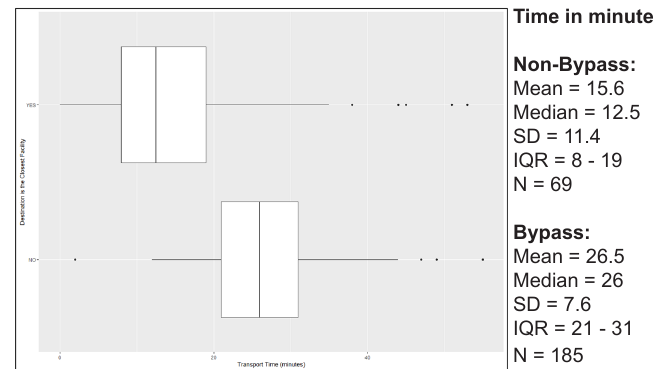
Figure 2. Comparison of actual transport time between bypass and non-bypass patients. Box and whisker plots represent median (middle line), IQR (borders of box from 25th (Q1) to 75th (Q3) percentiles), edges of lines represent values within (Q1 - 1.5*IQR) to (Q3 + 1.5*IQR); isolated dots represent outliers beyond the ±1.5*IQR values. SD , standard deviation; IQR , interquartile range.